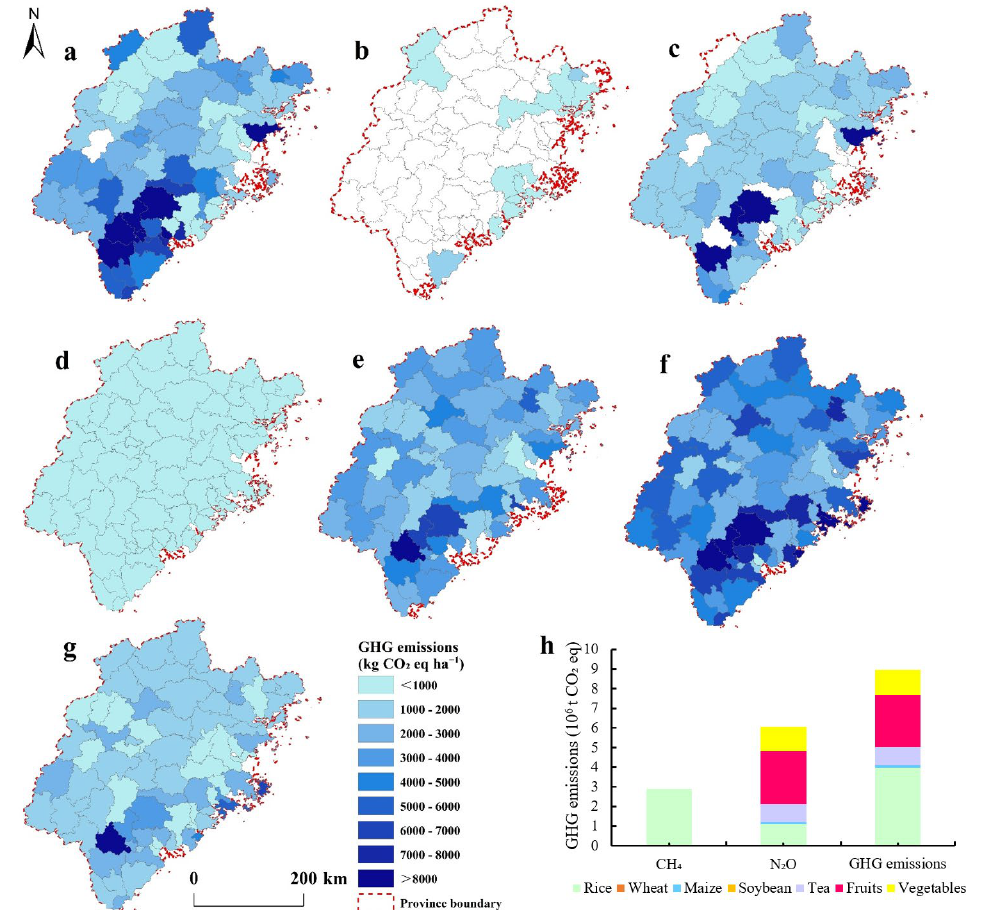
Figure 7. The spatial patterns of GHG emissions of various crops including rice ( a ), wheat ( b ), maize ( c ), soybeans ( d ), tea ( e ), fruits ( f ), and vegetables ( g ) at the county level in Fujian Province, as well as the GHG emissions amounts of various crops in Fujian Province ( h ).